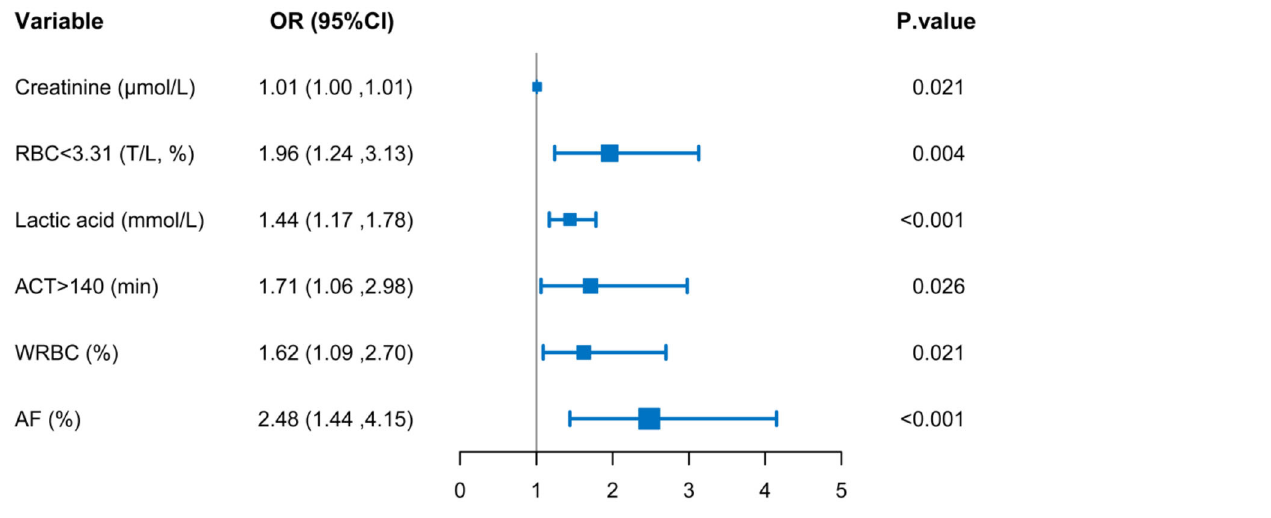
TABLE 2 | Logistic multivariable regression analysis showing the risk variables of ILI after AAD surgery.